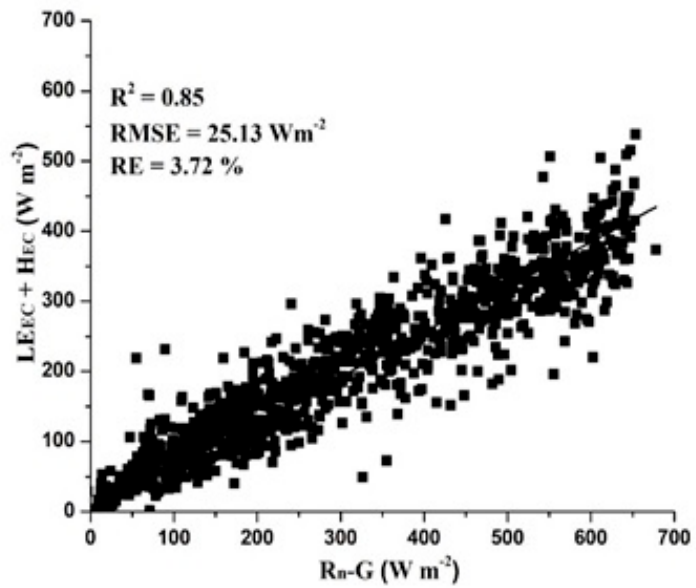
Figure 3. Half-hourly regression analysis between ( R n − G ) and ( LE EC + H EC ).